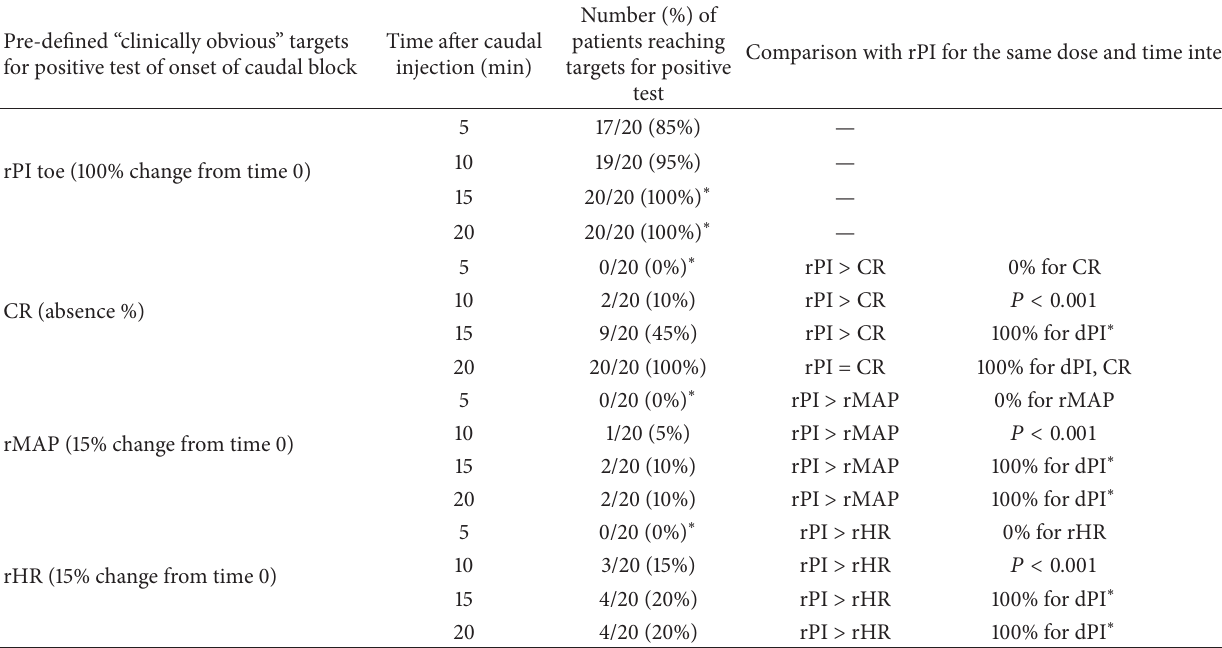
Table 3: Bedside indices for the onset of caudal block: numbers of patients meeting predefined “clinically obvious” targets indicative of onset of caudal block over time. Pre-defined “clinically obvious”